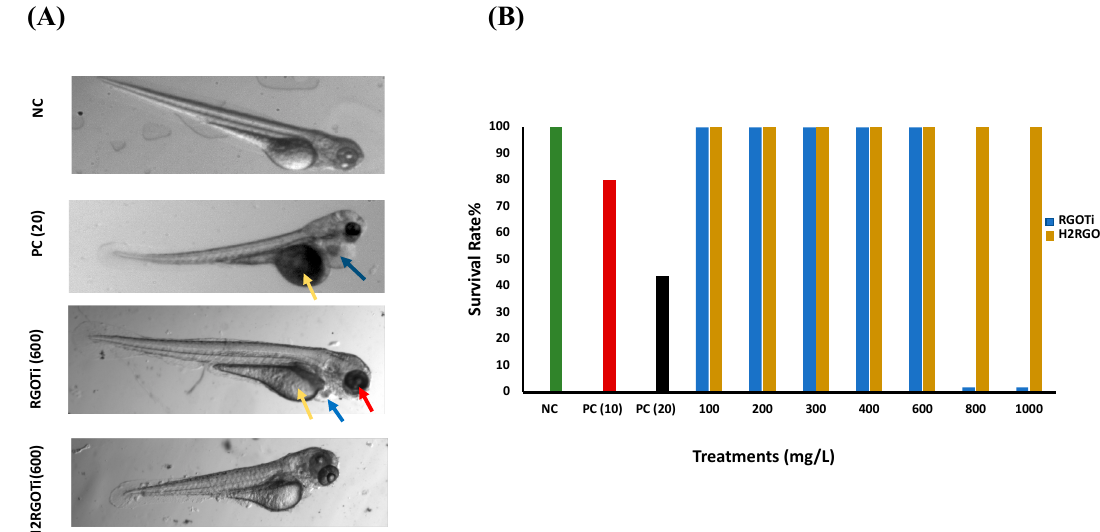
Figure 1. ( A ) Representative pictures (96-hpf) of acute toxicity experiments of ZnO nanoparticles-exposed embryos (positive control, PC), N-phenylthiourea (PTU) (negative control, NC) and the photolytic nanocomposites. Note the deformed embryos in 20.0 mg / L of the PC (yolk (yellow arrow) and cardiac edema (blue arrow)), thermally-reduced graphene oxide / TiO 2 semiconductor photocatalyst (RGOTi) (yolk, cardiac and increased eye size (red arrow)) and hydrogen-reduced graphene oxide / TiO 2 semiconductor photocatalyst (H 2 RGOTi) (smaller body size). ( B ) Acute toxicity and survival rate of embryos exposed at different concentrations of RGOT and H 2 RGOTi nanocomposites compared to the PC and NC, n = 50. Note: the edema in the hart and yolk and the eye size was measured by the ImageJ software. All the images were taken at the same magnification (20×).